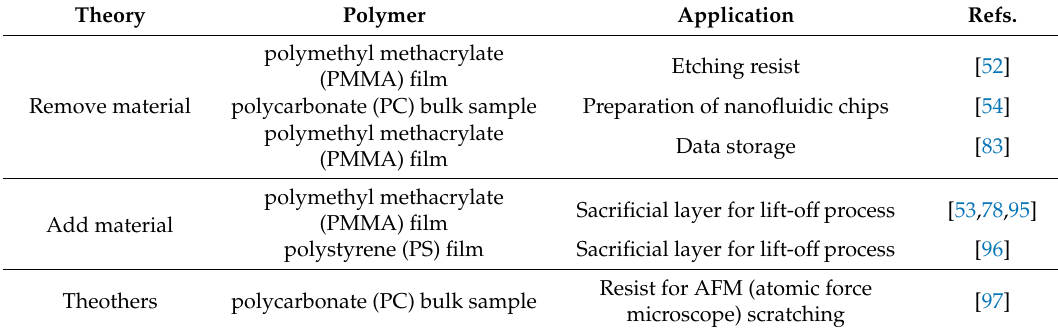
Table 1. The applications of scratching on polymers by the TBN